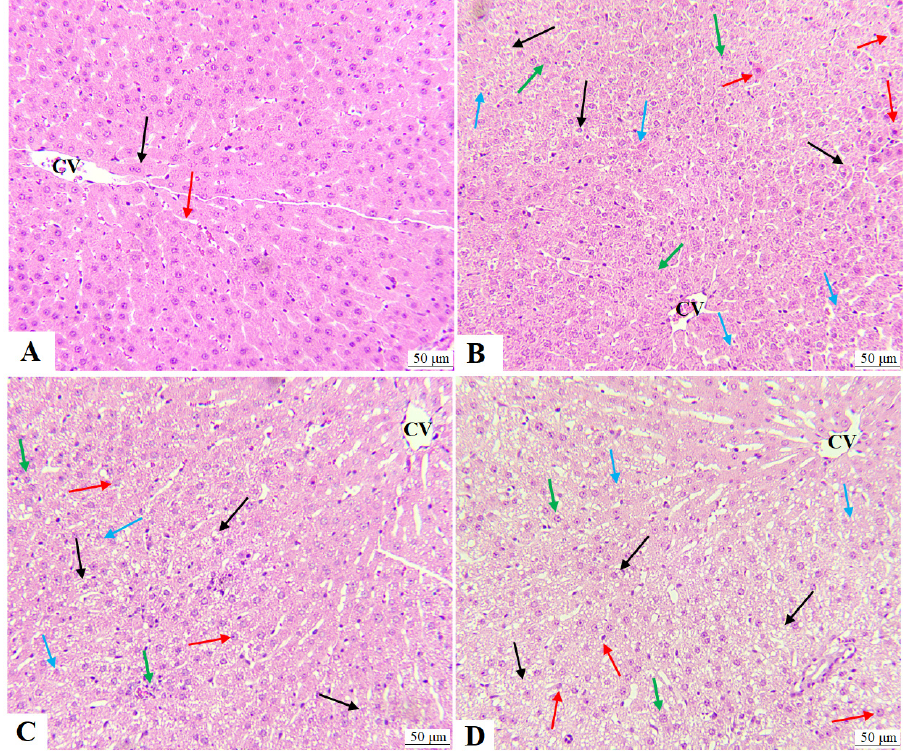
Figure 2. Histological pictures were obtained for the livers from all experimental groups and stained with hematoxylin and eosin (H&E). All photos were captured at 200 × . ( A ) is a control rat showing a normal central vein (CV) in which normally appeared hepatocytes with round nuclei (black arrow). In addition, the size of the sinusoid appeared normal (red arrow). ( B – D ) represent AuNPs, DOX, and DOX + AuNPs-treated rats, respectively, and show a damaged CV and increased number of hepatocytes with vacuolated and lipid-filled cytoplasm (black arrow). In addition, the nuclei of the hepatocytes of all these groups of rats showed pyknosis (red arrow), karyolysis (blue arrow), and karyorrhexis (green arrow). Note the increase in all these abnormalities in DOX + AuNPs-treated rats as compared to other groups.